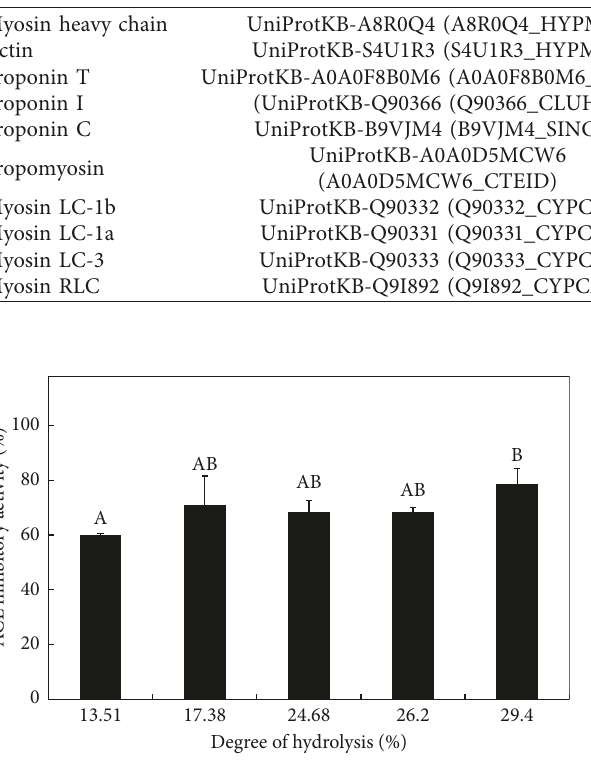
Table 1: Number of preferred amino acid residues for cleavage sites in the sequence of myosin, actin, tropomyosin, and troponin. Protein